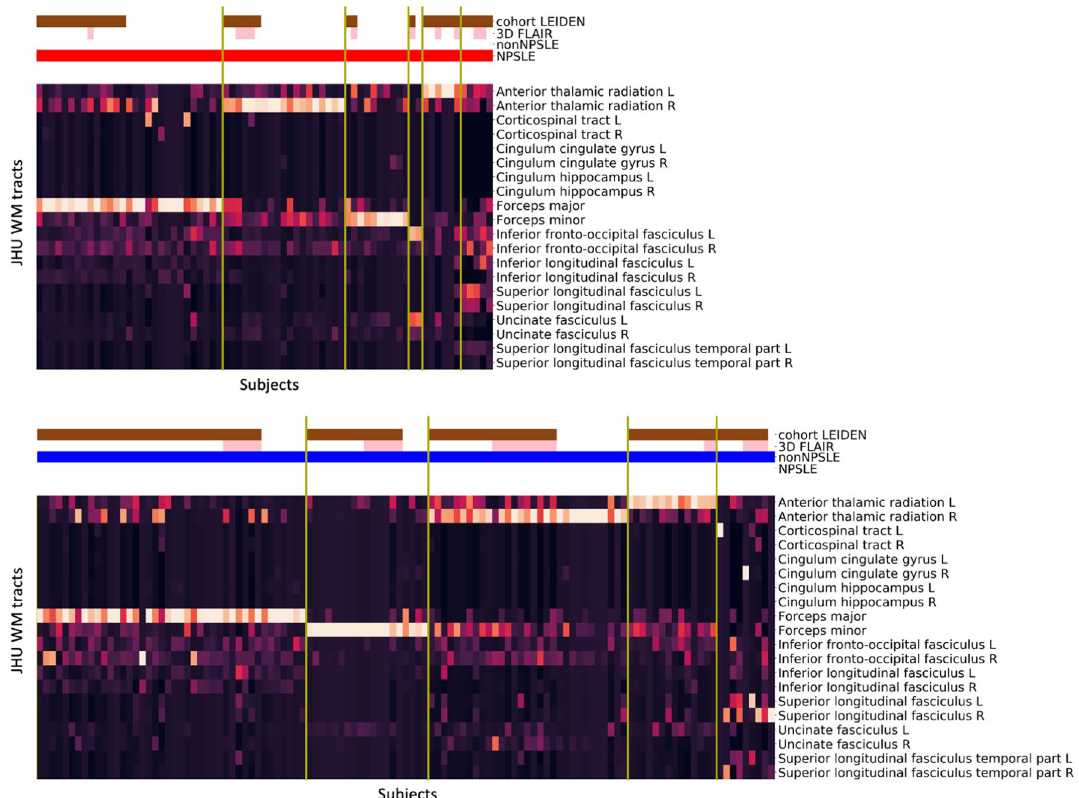
Figure 5. Sensitivity analysis on NPSLE and non-NPSLE patients. Cluster analysis on NPSLE patients (top) and on non-NPSLE patients (bottom). The horizontal bars at the top show additional information: Leiden cohort (brown) complemented by the Lund cohort, 3D-FLAIR (pink) complemented by 2D-FLAIR, non-NPSLE (blue), NPSLE (red). FLAIR, Fluid-attenuated inversion recovery; NPSLE, Neuropsychiatric systemic lupus